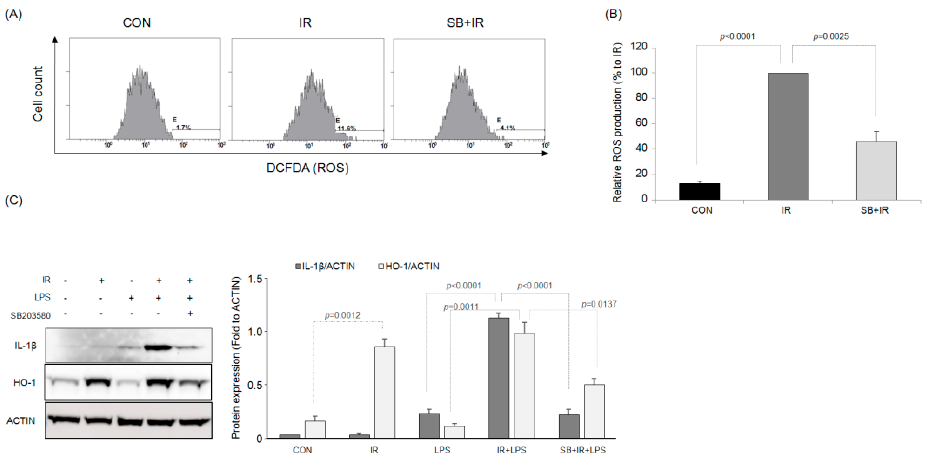
Figure 7. The p38 MAPK inhibitor SB203580 inhibits the ionizing radiation (IR)-mediated reactive oxygen species (ROS) production in RAW264.7 macrophages. ( A , B ) Production of ROS. ( C ) HO-1 protein expression. Bar graph results are expressed as mean value ± S.E.M.